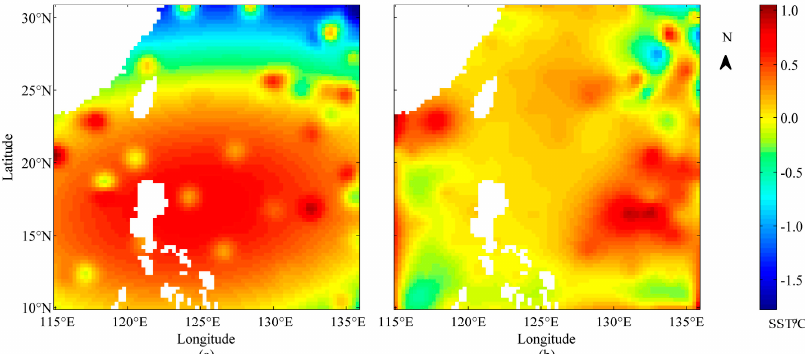
Figure 3. Reconstructed SST increments on 13 June 2014 obtained by using ( a ) Gaussian function and ( b ) multi-quadric function. White areas are lands in the images.